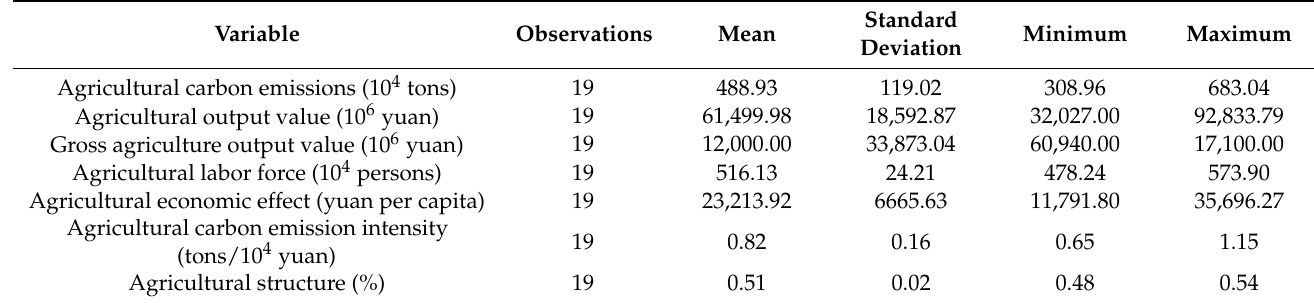
Table 3. Summary statistics of main